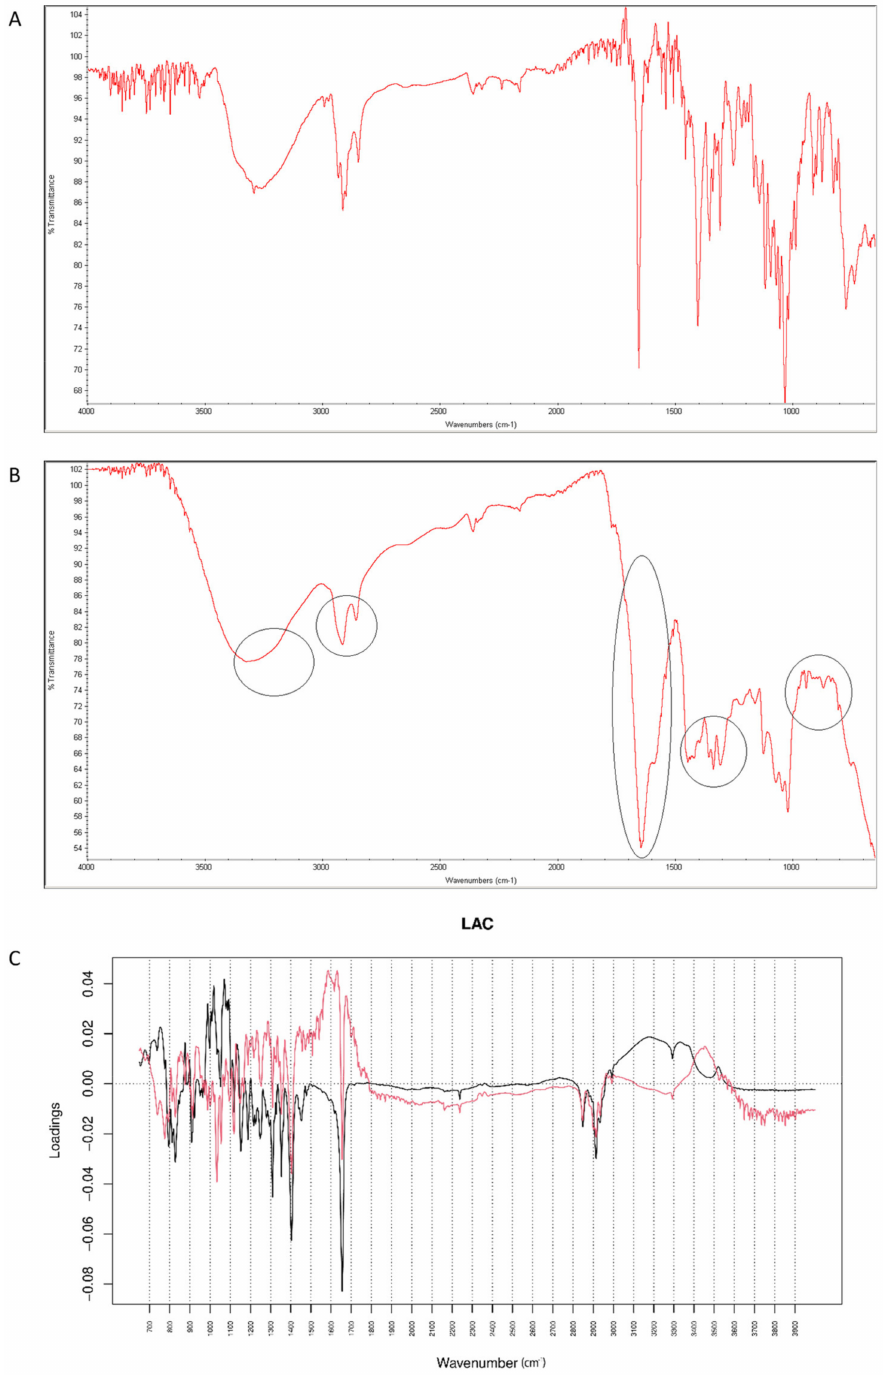
Figure 12. ( A – C ) Vildagliptin and lactose (LAC): mid-IR spectra of no stressed mixture ( A ), stressed mixture ( B ) and PCA loadings of the spectra ( C ); PC1 loadings are marked black while PC2 loadings are marked red; most visible differences in the spectrum of the stressed mixture are indicated with